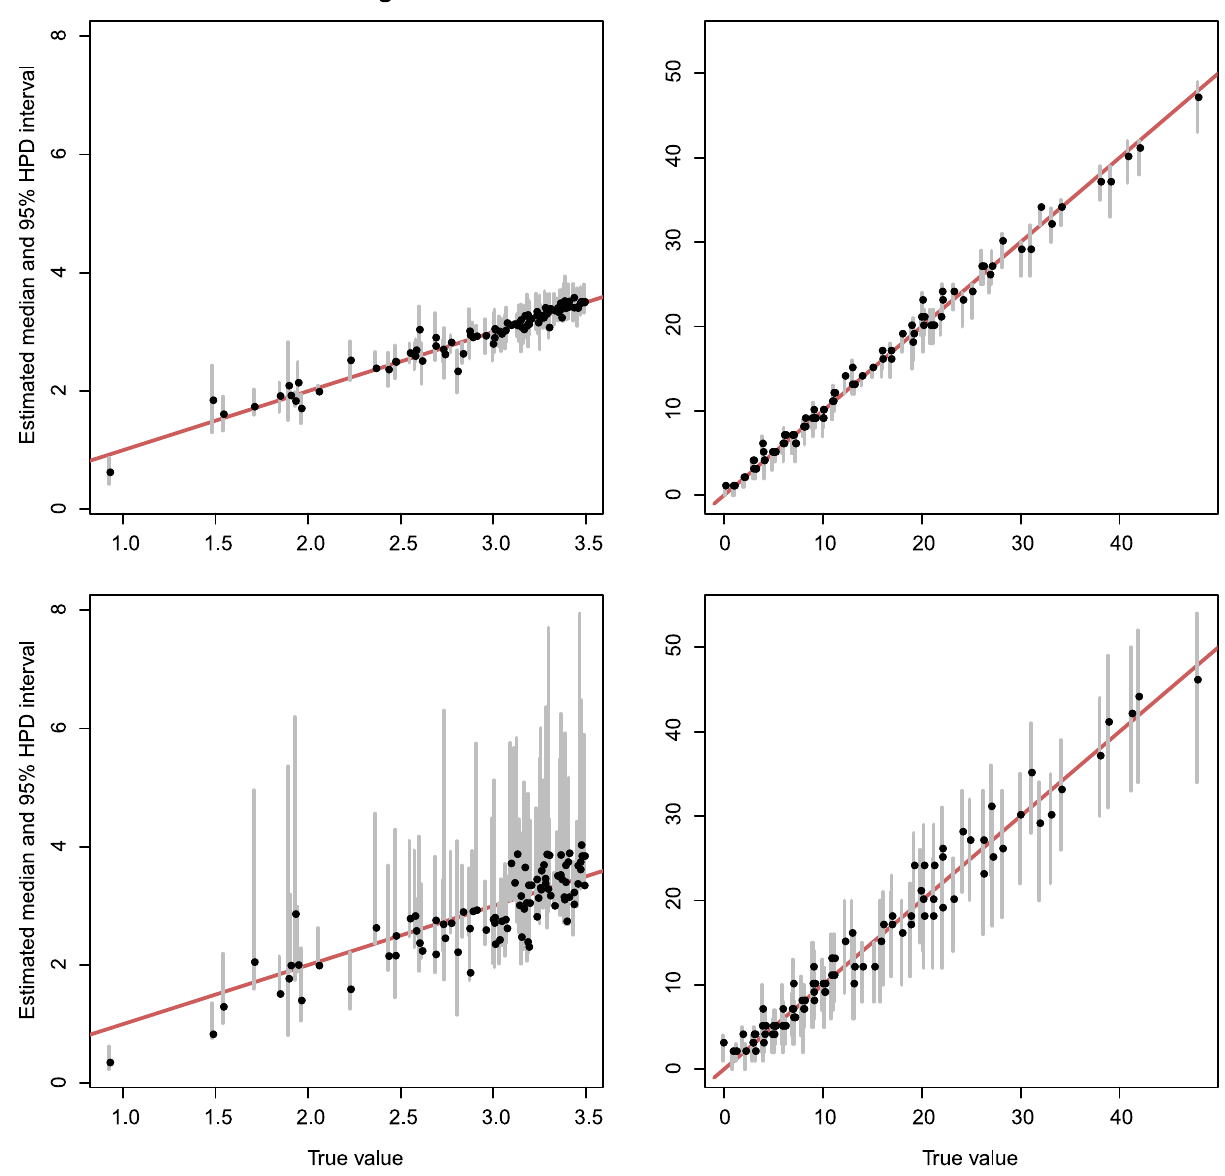
Figure 3. Properties of the tree estimated from simulated data (fossilized birth-death process). The graph shows median estimates (black dots) and 95% HPD intervals (grey lines) against true values for the tree height (on the left) and number of sampled ancestors (on the right). The upper row shows the estimates obtained from the analyses of simulated sequence data of all sampled nodes and the bottom row shows the estimates from the analyses where only sequence data from the extant samples was used. For some variants of the model, one of the tree model parameters has to be fixed for the inference to its true value as was discussed in the Methods section. Simulation studies show that fixing one of the parameters allows the recovery of the remaining parameter values. In particular, we showed that function (1) depends exactly on three parameters because fixing y allows recovery of l , m and r while function (2) depends on all four parameters: l , m , y and r . We also simulated scenarios where we fixed different parameters, for example, r or y . All scenarios give accurate estimates of the remaining parameter values.